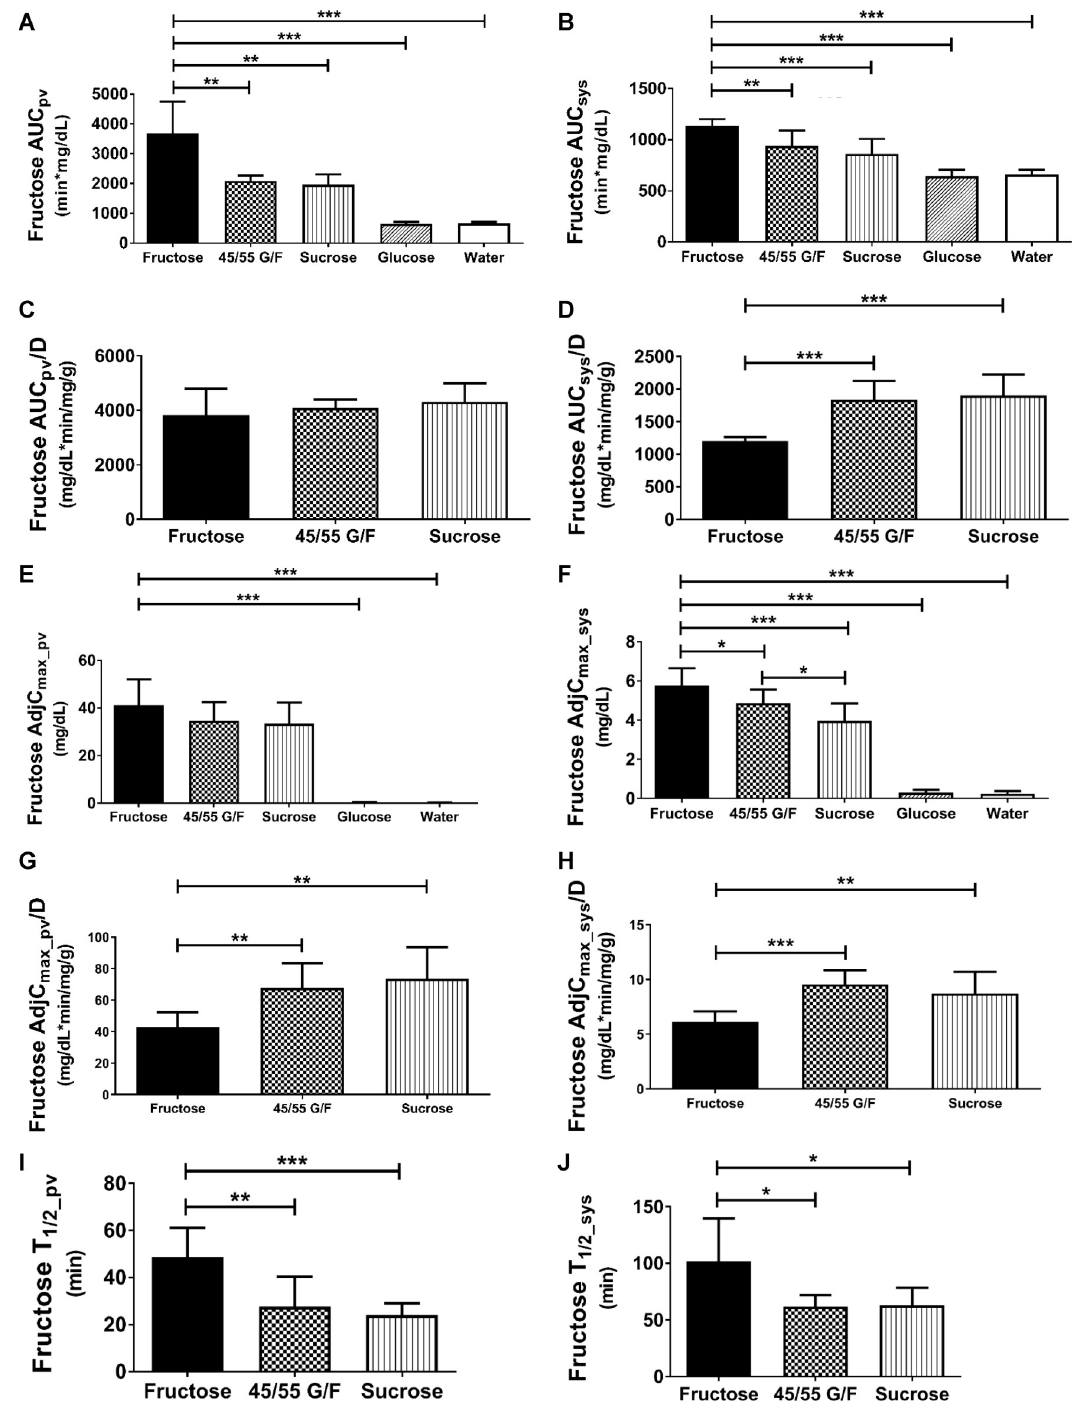
Fig 3. Effects of sugar-sweetened solutions after oral administration on fructose pharmacokinetic parameters. (A) Portal fructose area under the curve (AUC pv ) (B), systemic fructose area under the curve (AUC sys ), (C) normalized portal fructose area under the curve (AUC pv /D), (D) normalized systemic fructose area under the curve (AUC sys /D), (E) adjusted portal fructose maximal concentration (AdjC max_pv ), (F) adjusted systemic fructose maximal concentration (AdjC max_sys ), (G) normalized adjusted portal fructose maximal concentration (AdjC max_pv /D), (H) normalized adjusted systemic fructose maximal concentration (AdjC max_sys /D), (I) portal fructose half-life (T 1/2_pv ), and, (J) systemic fructose half-life (T 1/2_sys ). 45/55 G/F = 45% glucose/55% fructose. P-value: � < 0.05, �� < 0.01, and ��� < 0.001.